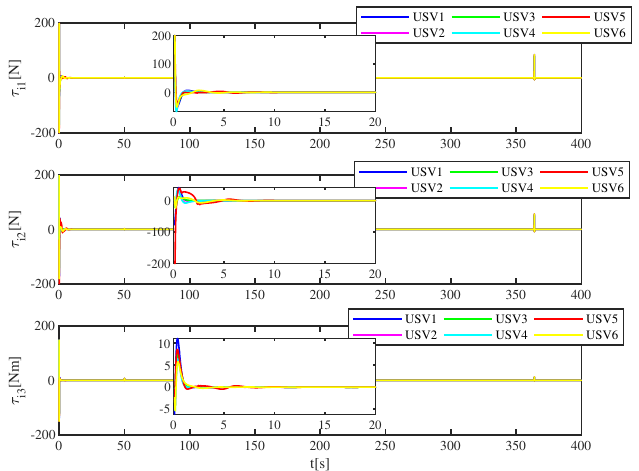
Figure 11. Control input of six USVs using NADSC without ADS and input